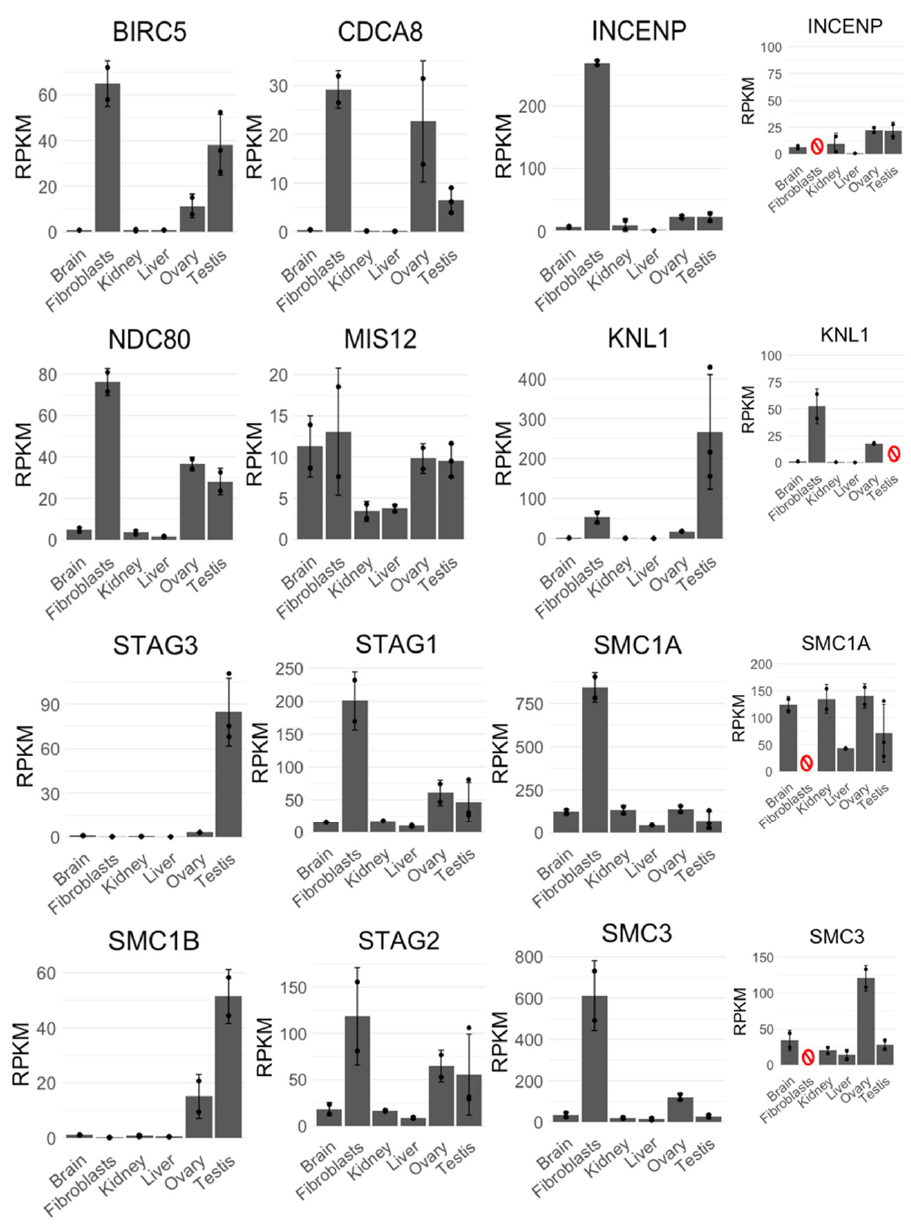
Figure 5. Expression profiles of CPC (BIRC5, CDCA8, INCENP), KMN complex (KNL1, MIS12, NDC80), and cohesins (STAG1—3, SMC1A, SMC1B, SMC3) obtained from single-end transcriptome datasets originating from RNA sequencing of different platypus tissues. Error bars represent standard deviation of mean RPKM calculated from two datasets per each tissue, except testes, where three sets were obtained. The rightmost expression profiles (INCENP, KNL1, SMC1A, and SMC3) also have smaller insets representing the data after removing (red symbol) the tissue with the highest RPKM value, which otherwise masks smaller RPKM values of other tissues in the original charts (i.e., testis for KNL1 and fibroblasts for INCENP, SMC1A, and